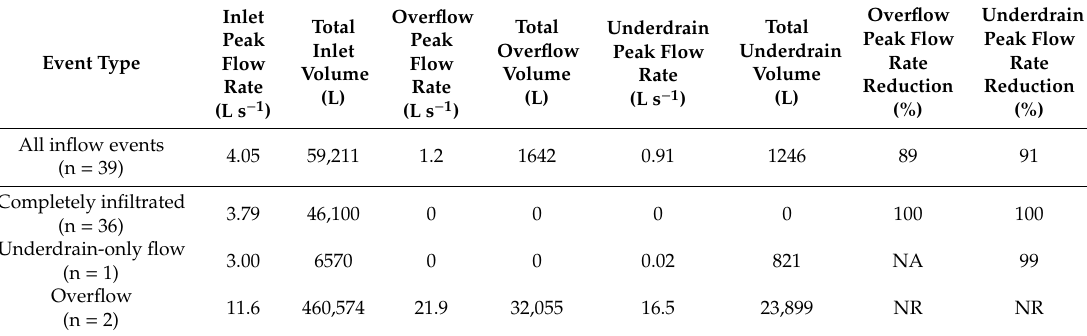
Table 4. Mean volume and flow for each storm event scenario.